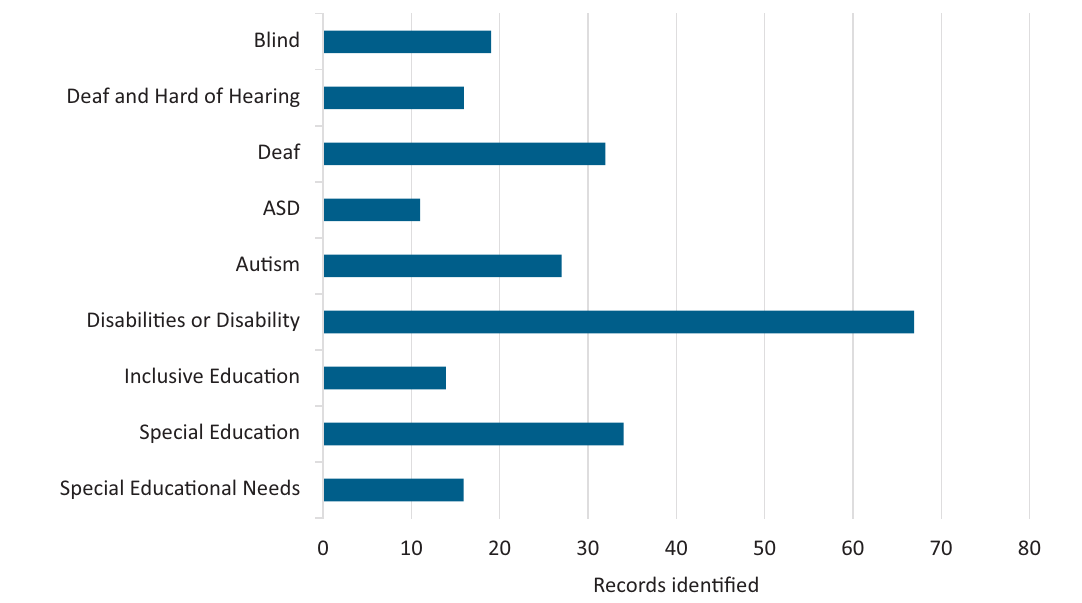
Figure 2. Records identified with each specific filter.